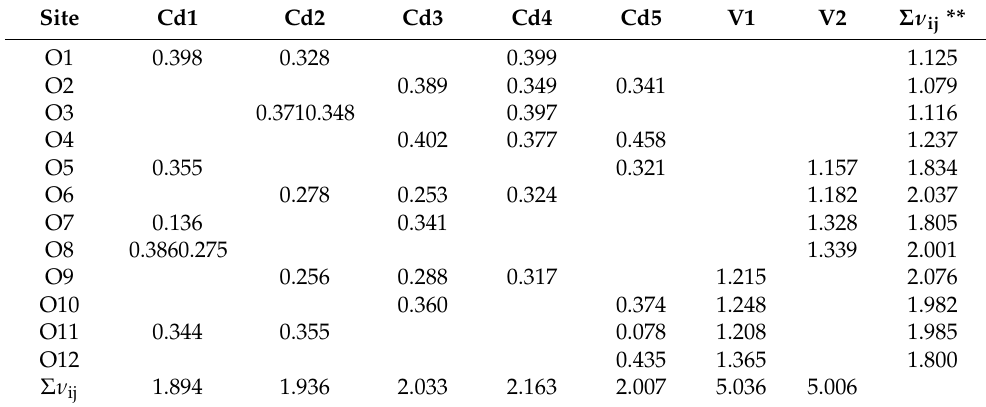
Table 4. Bond valences and bond valence sum Σ ν ij (v.u.) for Cd 5 (VO 4 ) 2 (OH) 4